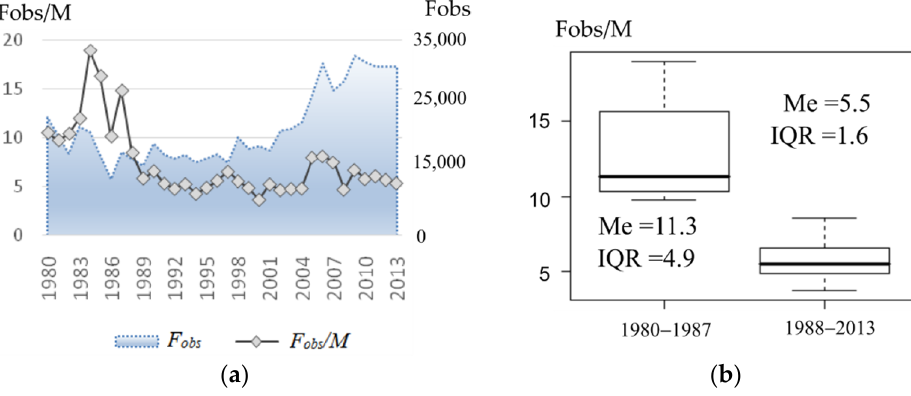
Figure 4. ( a ) Average observed number of females per male (or average observed harem size, on the left axis) and observed number of females (on the right axis) at the rookery. ( b ) Box plots of average observed harem size corresponding with two periods: 1980–1987 and 1988–2013.